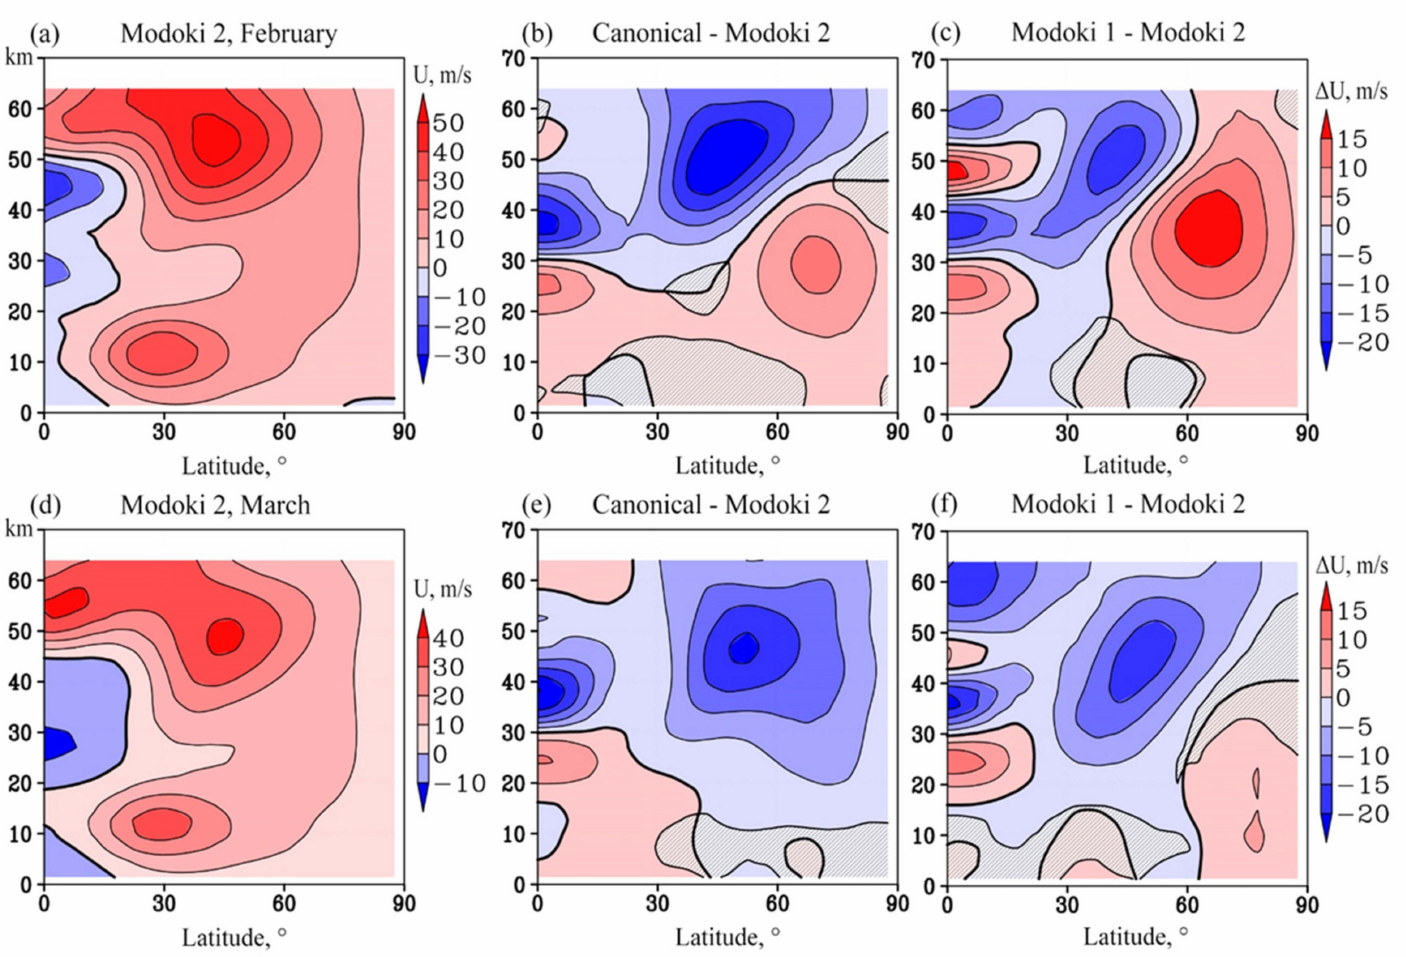
Figure 4. Monthly averaged zonal mean wind (m/s) in February ( a – c ) and March ( d – f ) during Modoki II El Niño event ( a , d ); difference between Canonical and Modoki II ( b , e ); difference between Modoki I and Modoki II ( c , f ).Hatched areas show insignificant data (at